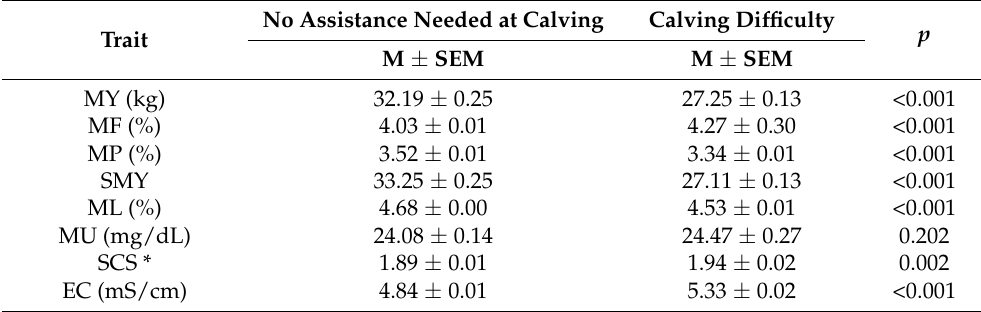
Table 3. Milk yield and composition and somatic cell count in cows with calving difficulty and with no assistance needed at